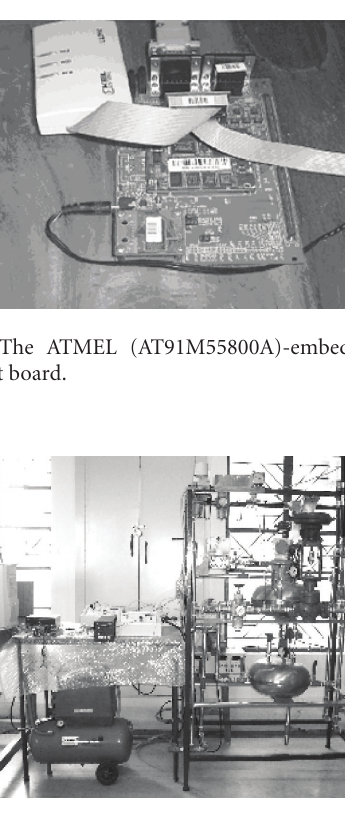
Figure 7: Photograph of the experimental